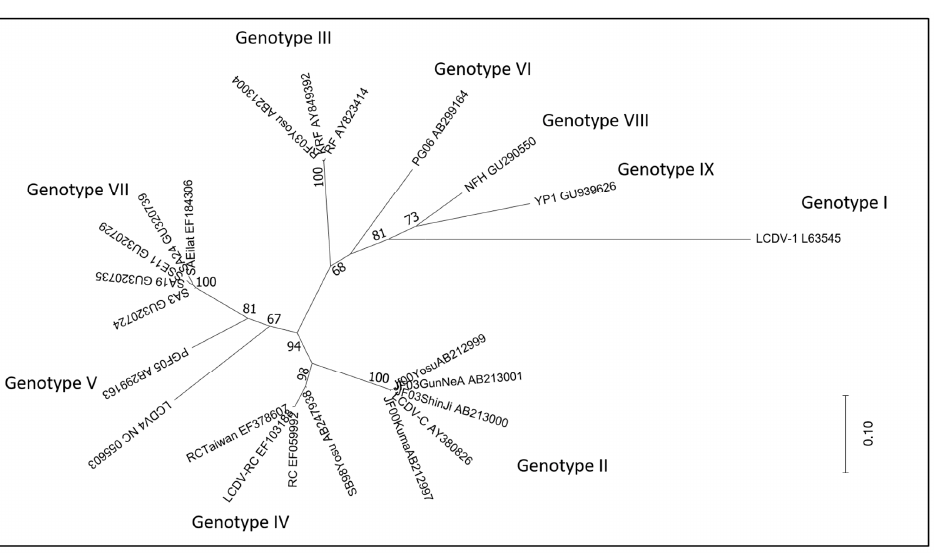
Figure 1. Maximum likelihood phylogenetic tree (MEGA 6 software) constructed with the major capsid protein (MCP) gene of LCDVs detected in several fish species. Strains are reported with the isolate name and GenBank accession number. Bootstrap values (1000 replicates) above 65% are shown. Substitutions per site are reflected by branch lengths (scale at bottom right).